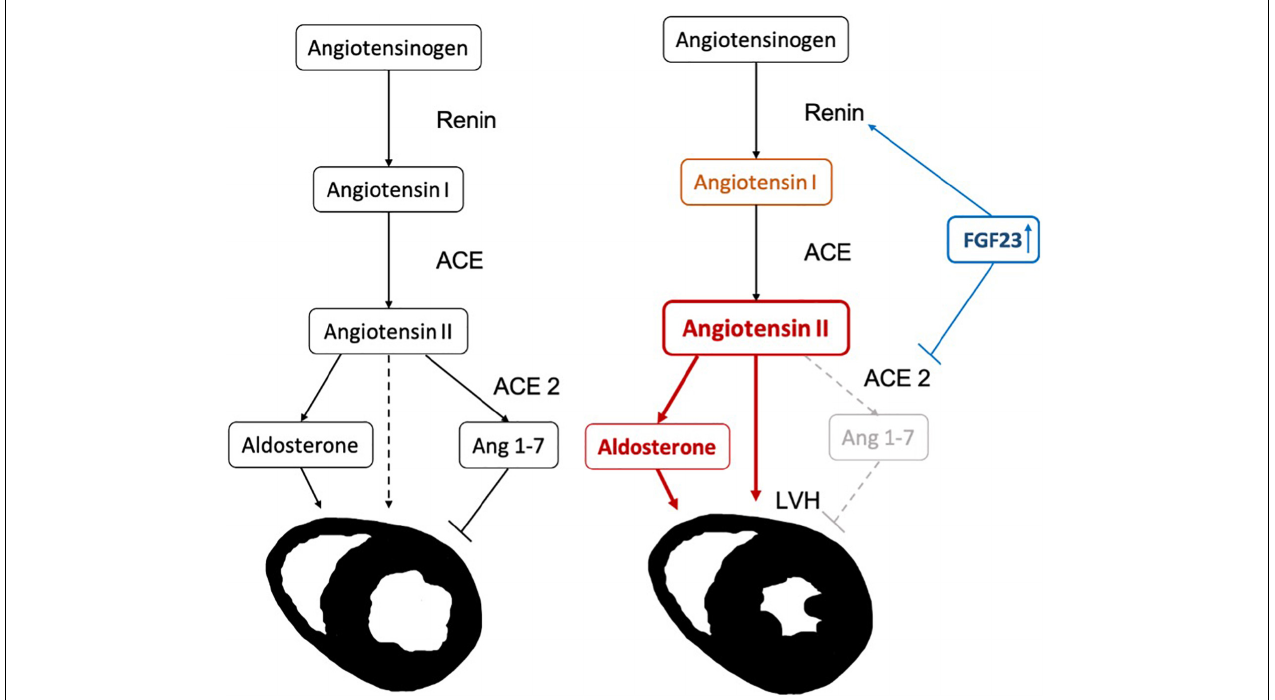
FIGURE 1 | Hypothesis for the progression of left ventricular hypertrophy (LVH) due to FGF23 induced activation of the renin-angiotensin-aldosterone system (RAAS) cascade: FGF23 increases renin (indirectly by reducing the levels of active vitamin D). In addition, the levels of ACE2 are inhibited, increasing AngII and decreasing Ang(1-7), causing an increase in left ventricular